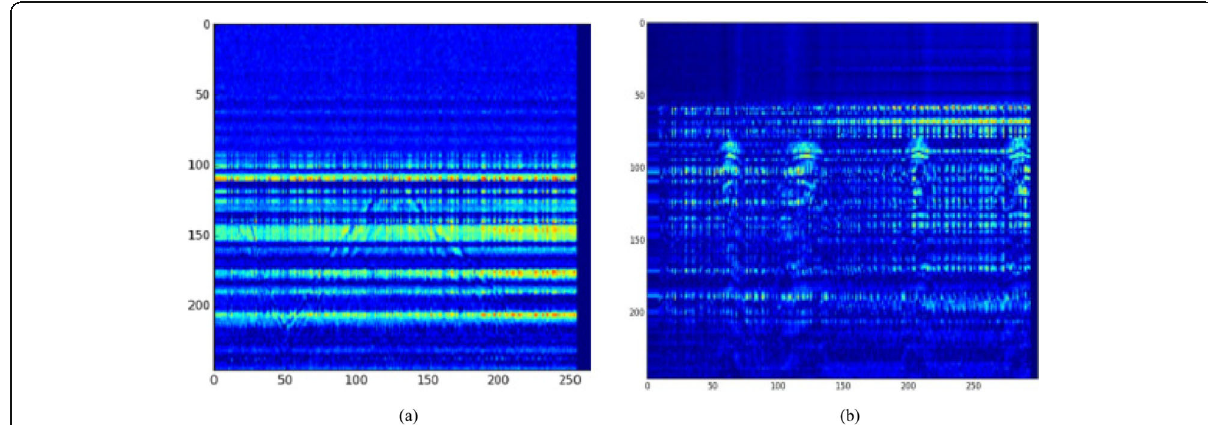
Fig. 11 Imaging results received by moving target. a The imaging results when the target was moving perpendicular to the system. b The